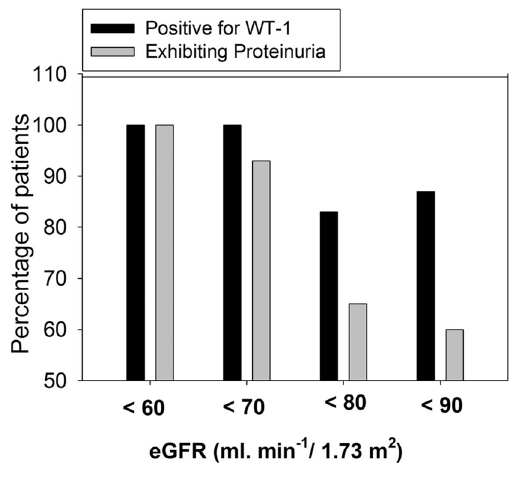
Figure 4. Comparison of WT-1 expression and presence of proteinuria (ACR) in diabetic patients at various eGFR cutoffs. Bar graph showing percentage of patents detected with proteinuria or WT1 expression in urinary exosomes at various cutoff values of eGFR between 60–90 ml. min 2 1 /1.73 m 2 ). WT-1 expression was detected in higher percentage of patients at earlier fall in GFR (eGFR , 70/80/90 ml. min 2 1 /1.73 m 2